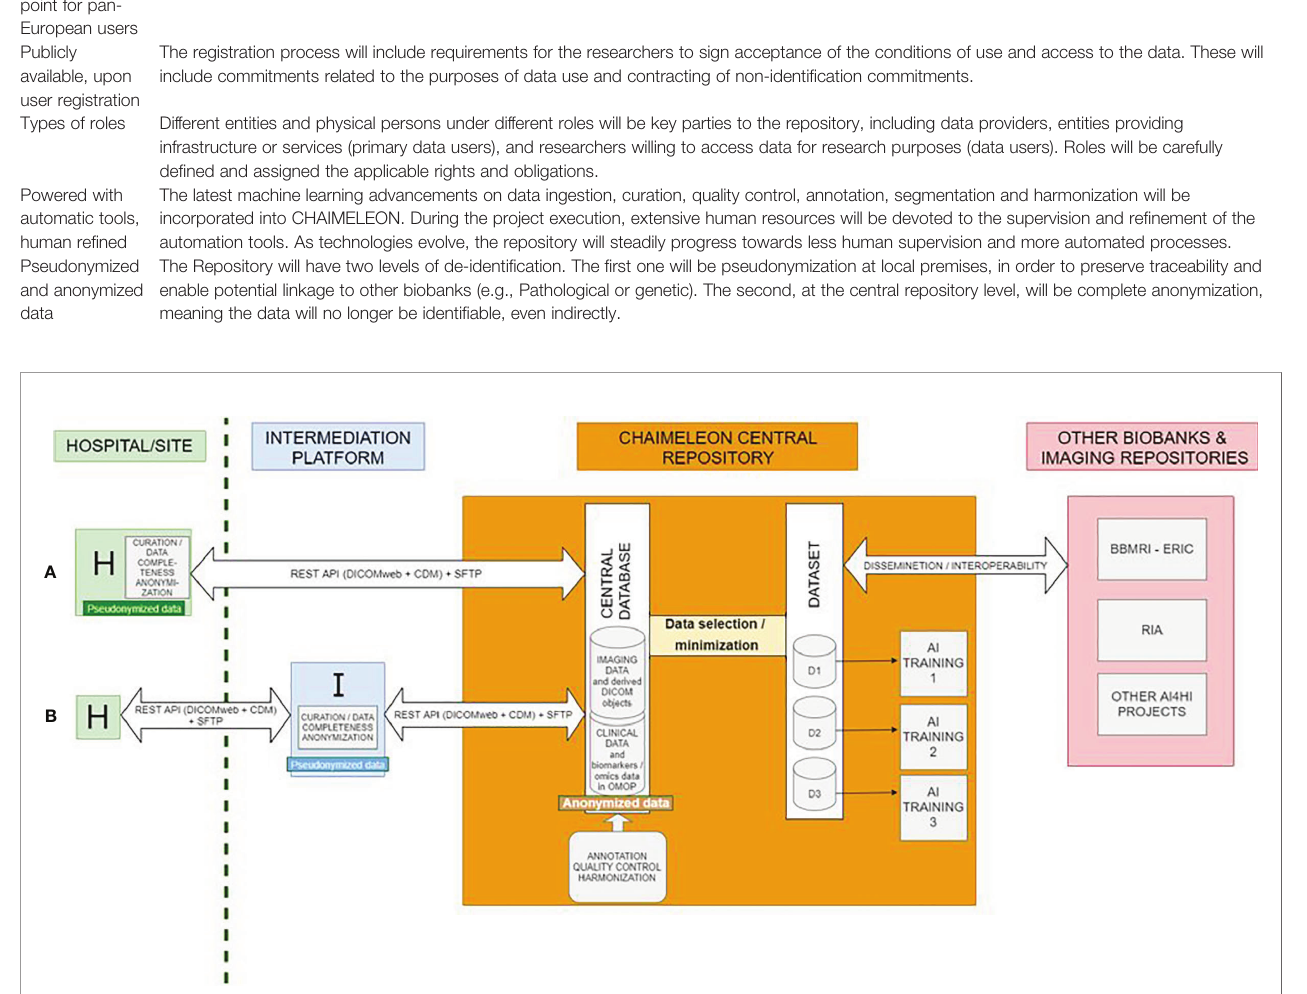
FIGURE 2 | Distributed architecture and IT infrastructure. (A) and (B) refer to two different types of hospitals based on their capacity to curate, complete, and anonymize data prior to their ingestion into the central repository. (A) Data processing is done on site. (B) Data processing is done via an intermediation platform.